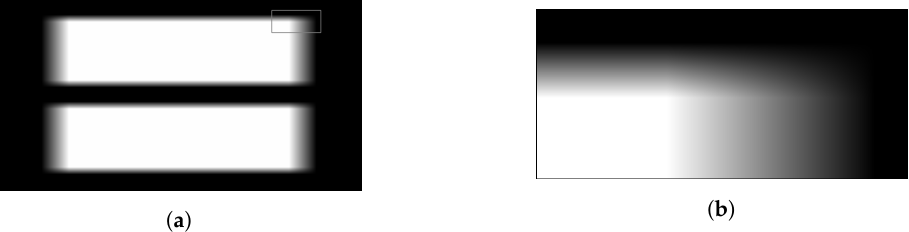
Figure 4. ( a ) Spatial filter to balance intensity on edges of the elemental volume hologram plane. ( b ) Closeup of the top right corner of the filter area as marked with rectangle in ( a ). f ( x , y ) = f x ( x ) f y ( y ) .